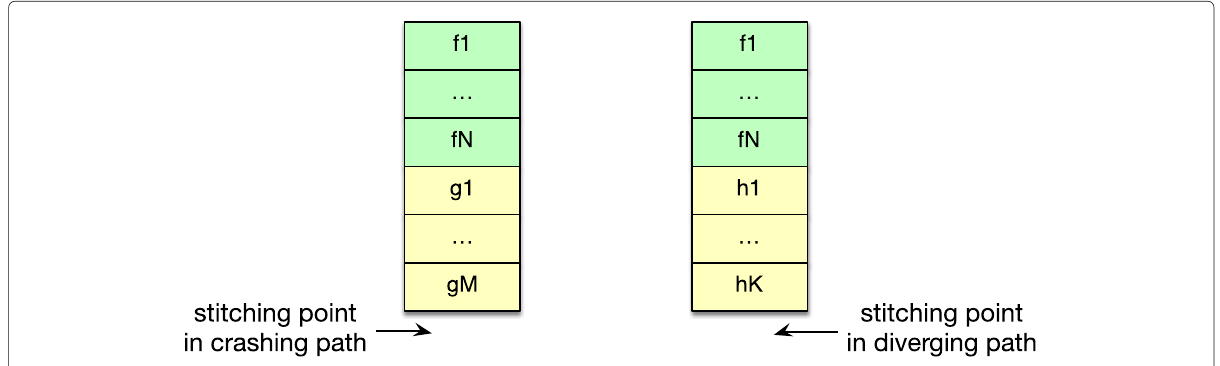
Fig. 9 Example call stacks of stitching